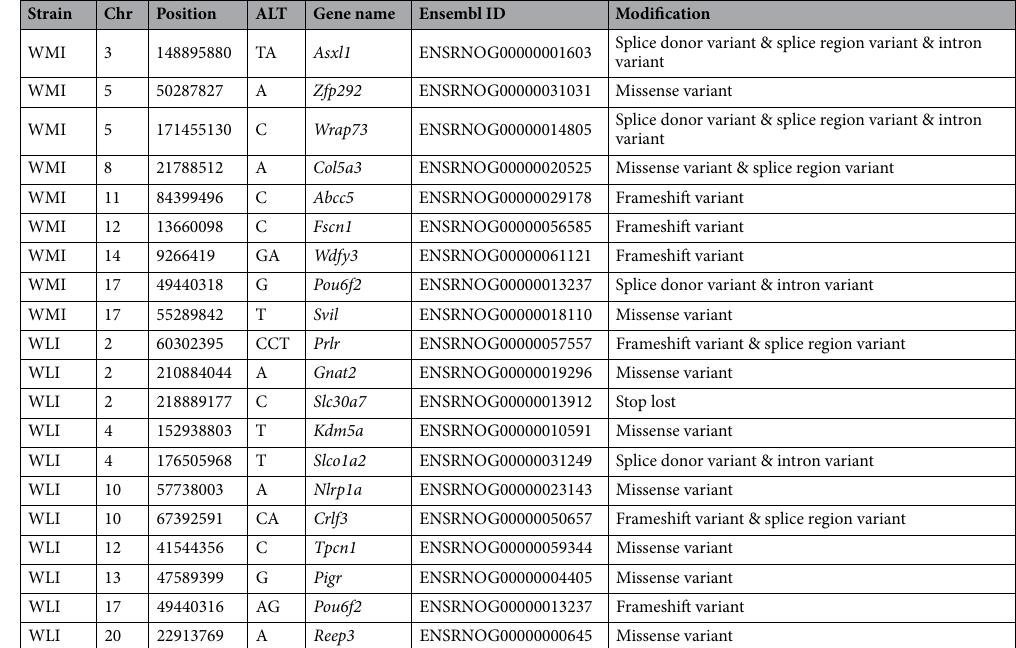
Table 3. Overview of variants of high and moderate impact, their impact and the gene